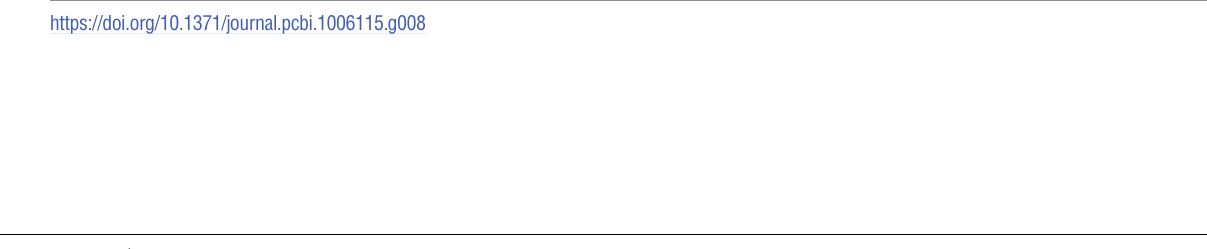
PLOS Computational Biology | https://doi.org/10.1371/journal.pcbi.1006115 June 26,